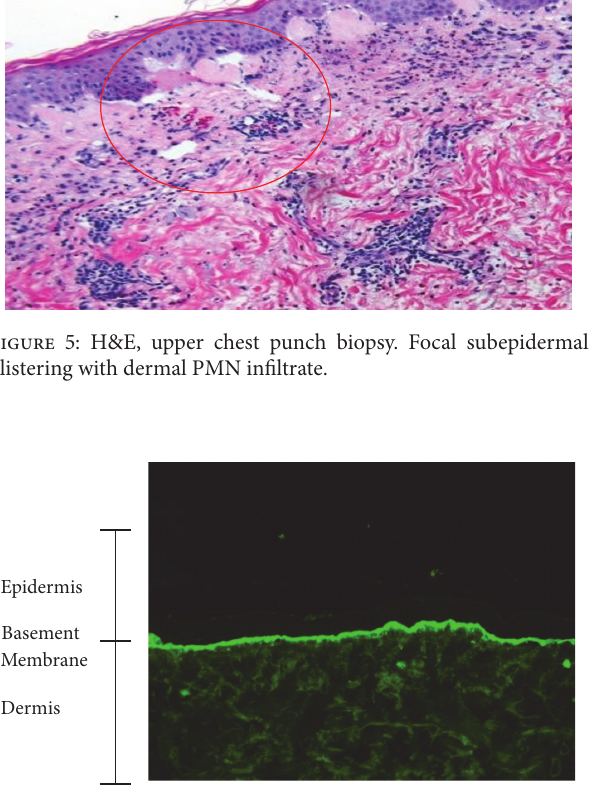
Figure 6: Direct immunofluorescence, upper chest punch biopsy. Linear IgA deposition along the basement